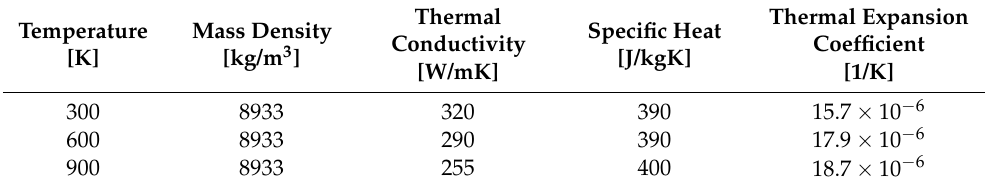
Table 3. Thermal and physical properties of CuCrZr alloy [5].